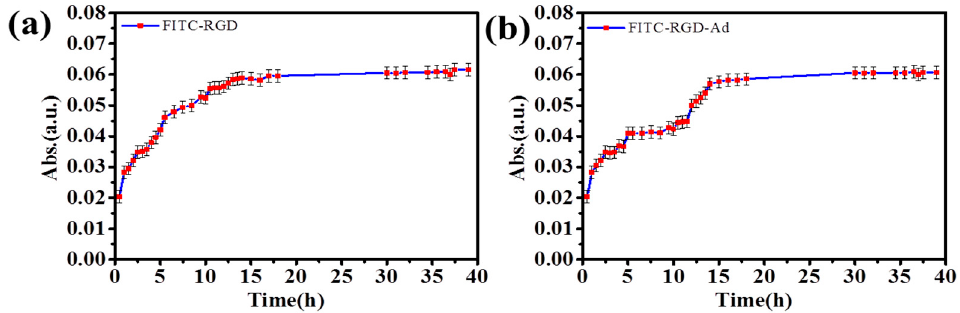
Figure 6. The release plots of ( a ) FITC-RGD and ( b ) FITC-RGD-Ad from (PAH/SiO 2 ) 1 /(PAH/HA-CD) 20 /(PAH-SiO 2 ) 1 /(PAH/HA-CD) 20 laminated multilayer films.